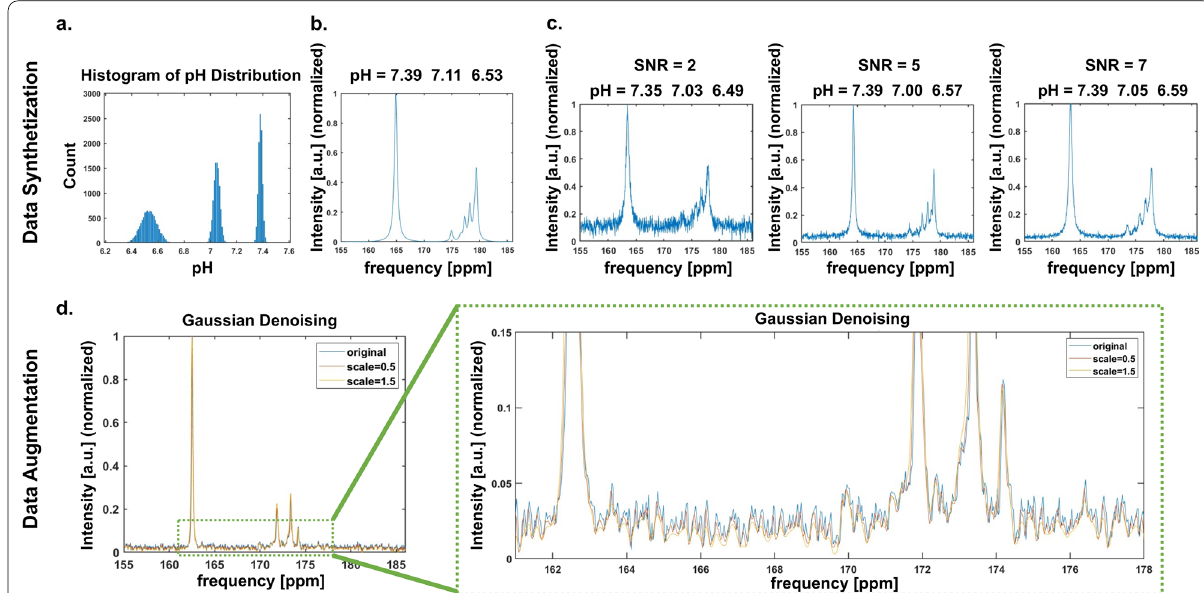
Fig. 2 Spectra synthetization was performed to generate three pH e compartment spectra for the CNN and MLP training data. a The pH e values for each of the three compartments (7.33–7.44; 6.96–7.15; 6.32–6.78) are normally distributed. b An example of the generated spectrum by 3 compartment pH e values. c Signal‑to‑noise (SNR) ratios are applied ranging from 2 to 7 for the synthetic spectra. For simplification, only SNR 2, 5, and 7 are shown. Kidney spectra were augmented by applying five‑scale Gaussian denoising to increase the real training data size. d Example of the original and denoised spectra. For simplicity, only the first and the fifth scale‑denoised spectra are shown. An enlarged version of the spectra (green box) is shown on the